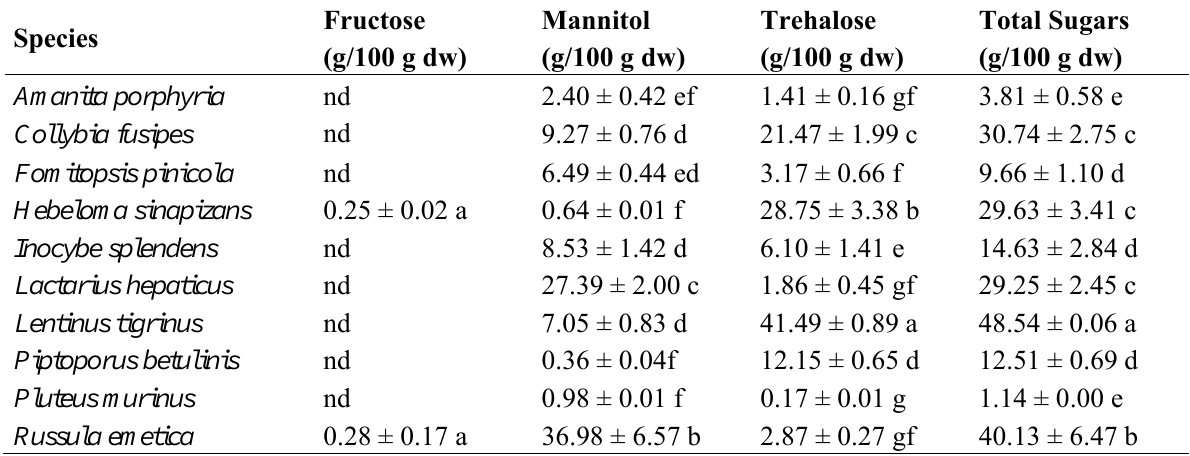
Table 1. Biomolecules (free sugars) with energetic value.